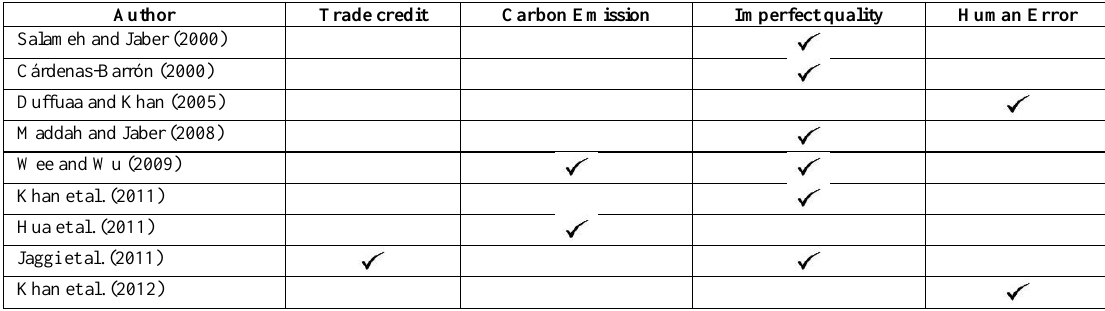
Table 1. Contribution of different